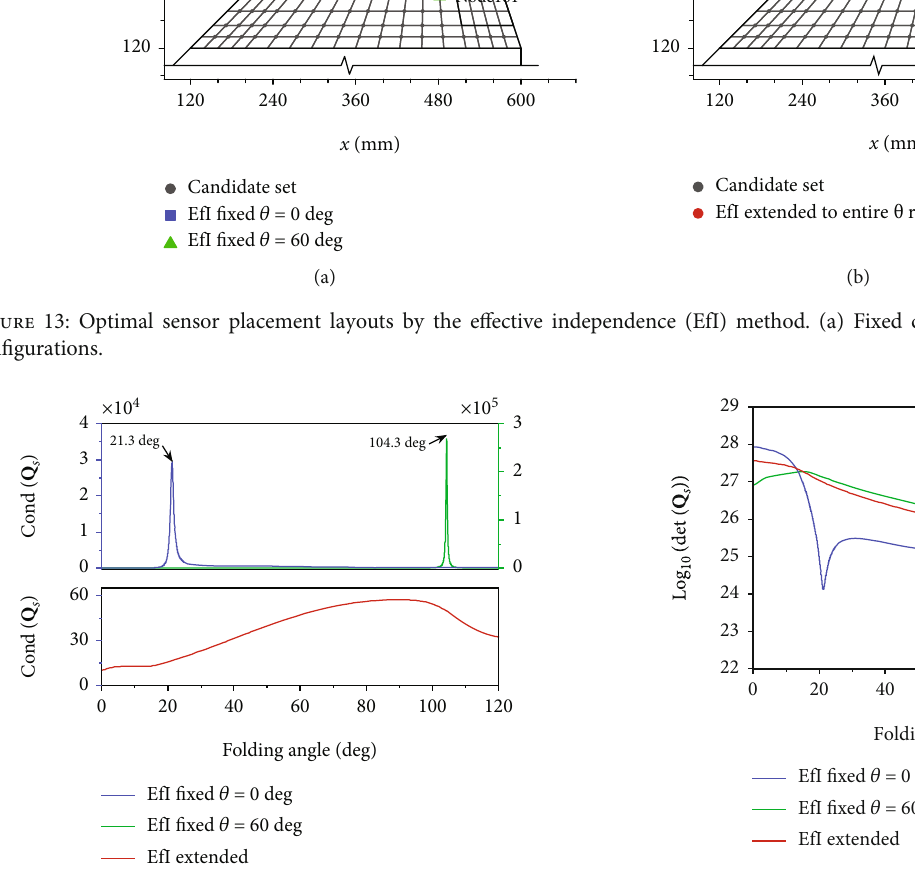
Figure 14: Condition number of the information matrix varying with the folding angle under di ff erent sensor